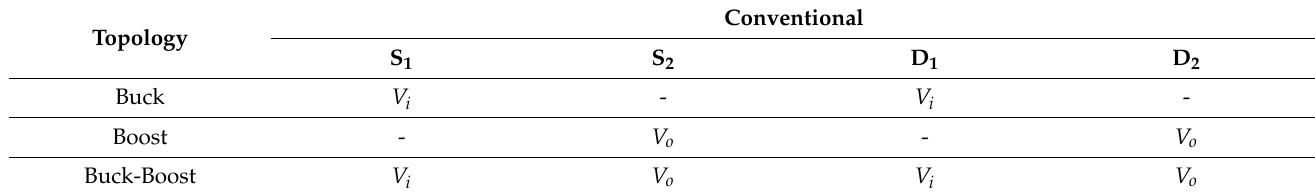
Table 6. Comparison of stress in each TSBB converter: (a) Voltage stress; (b) Current stress. Topology